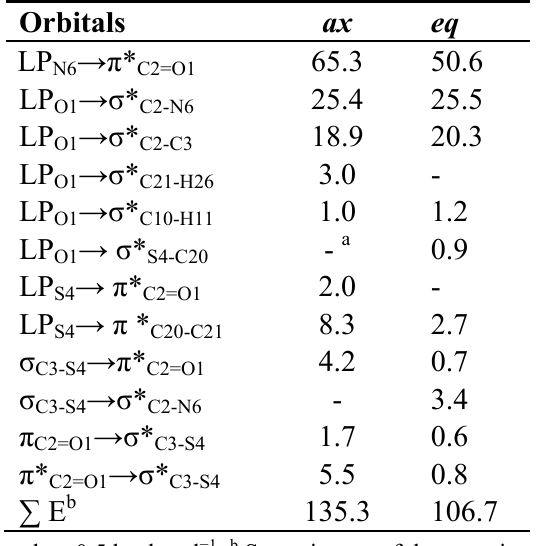
Table 5. Comparison of significant NBO energies (kcal mol − 1 ) of the corresponding interacting orbitals for the conformers ax and eq of 3-phenylsulfanyl-1-methyl-2-piperidone 4 at the B3LYP/6-31+G(d,p)